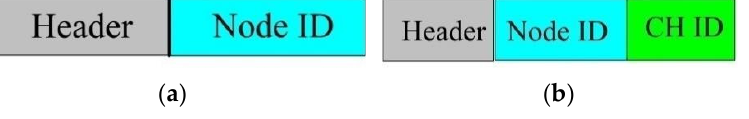
Figure 2. ( a ) ADV message. ( b ) REQ message.